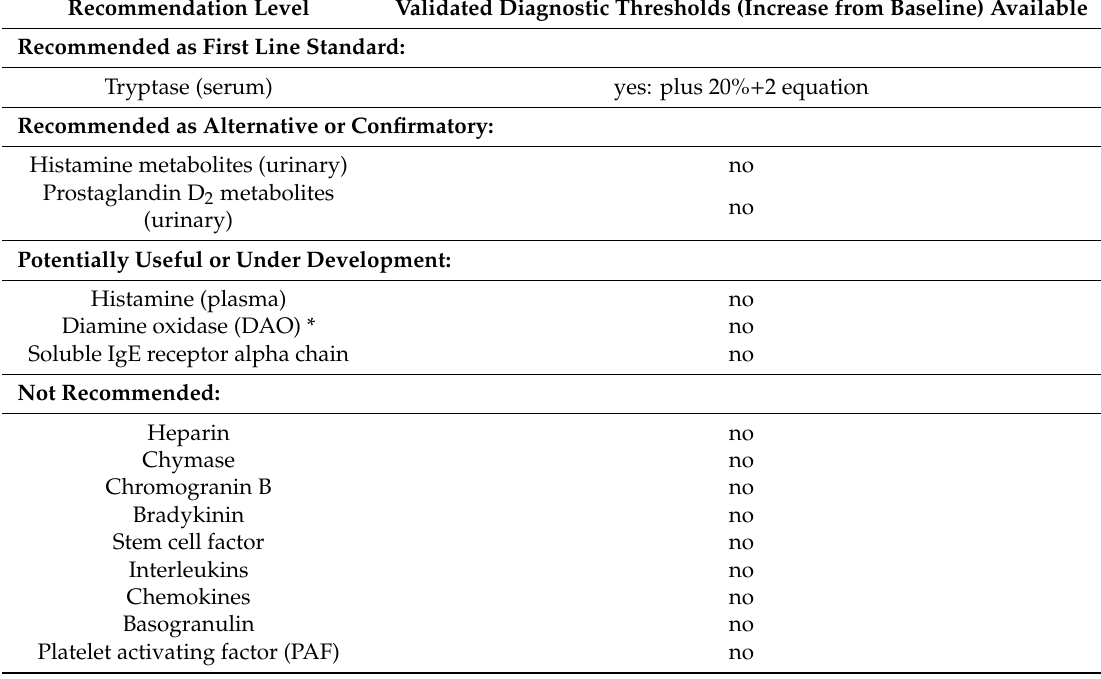
Table 3. Mast Cell Mediators recommended as Markers of Systemic MCA in Practice. Recommendation